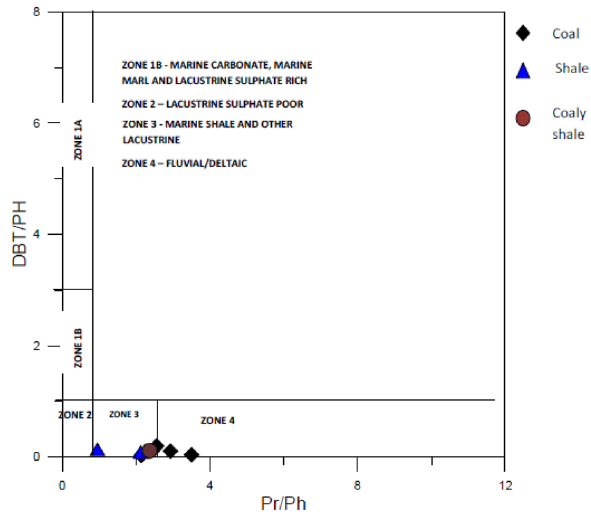
Fig. 18 Cross plot of dibenzothiophene/phenanthrene (DBT/PH) versus pristane/phytane (Pr/Ph) of coaly and shaly source rocks of Maiganga, Gombe Formation (Hughes et al. 1995). The coals, shale and coaly shale plotted in Zones 3 and 4 (Marine shale, lacustrine and fluvial/deltaic environment)